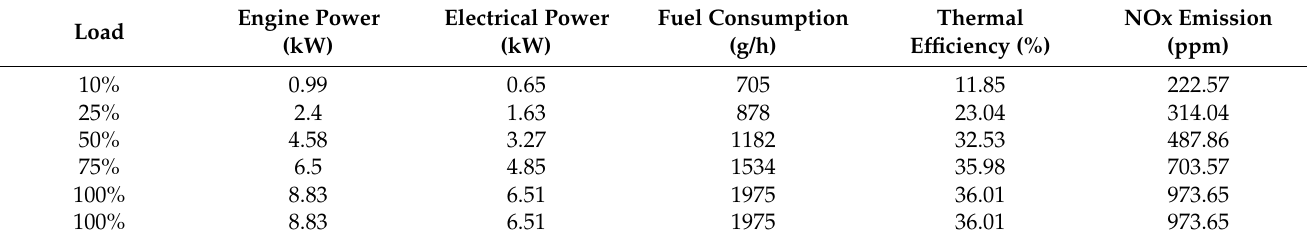
Table 2. Engine Performance Under Different Loads